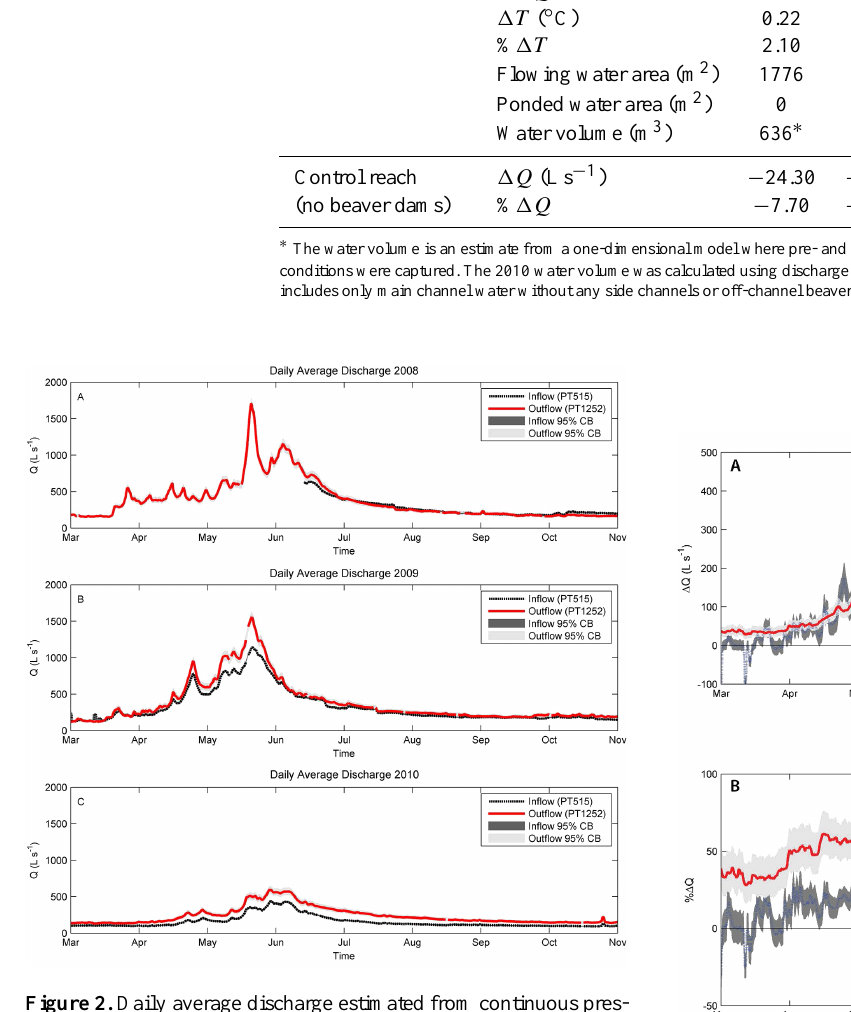
Figure 2. Daily average discharge estimated from continuous pres- sure transducer records spanning 2008–2010 (a–c) . The black- dashed line represents upstream, inflow conditions at PT515 and the red-solid line represents downstream, outflow conditions at PT1252. The individual 95 % confidence intervals around discharge estimates are represented by grey shading. Note that the inflow bounds are very small and are, therefore, not visible in the figure.